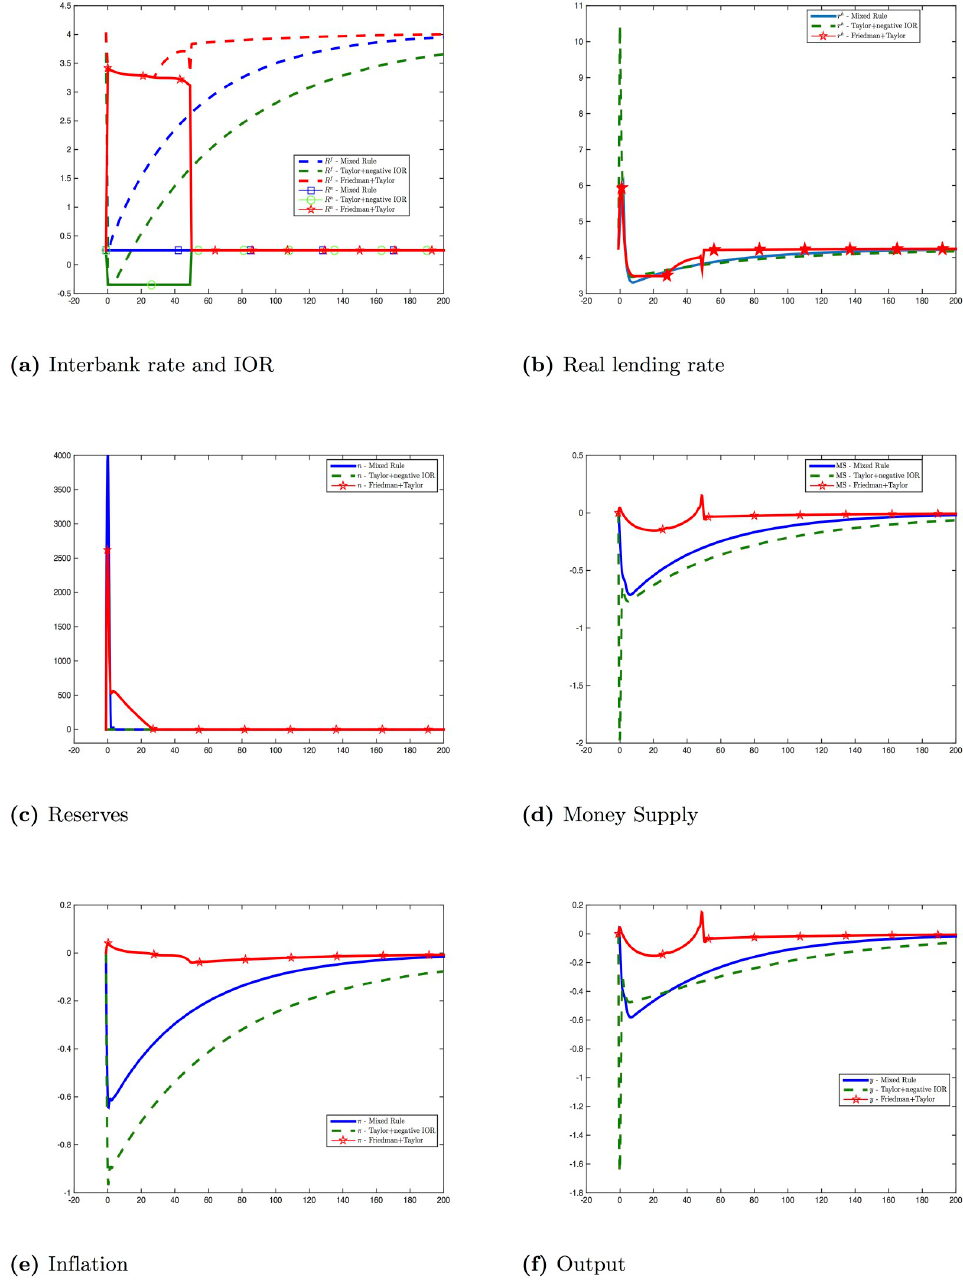
Fig 5. Financial crisis—Friedman+Taylor (M6) vs mixed rule (M5) vs Taylor+negative IOR (M3).